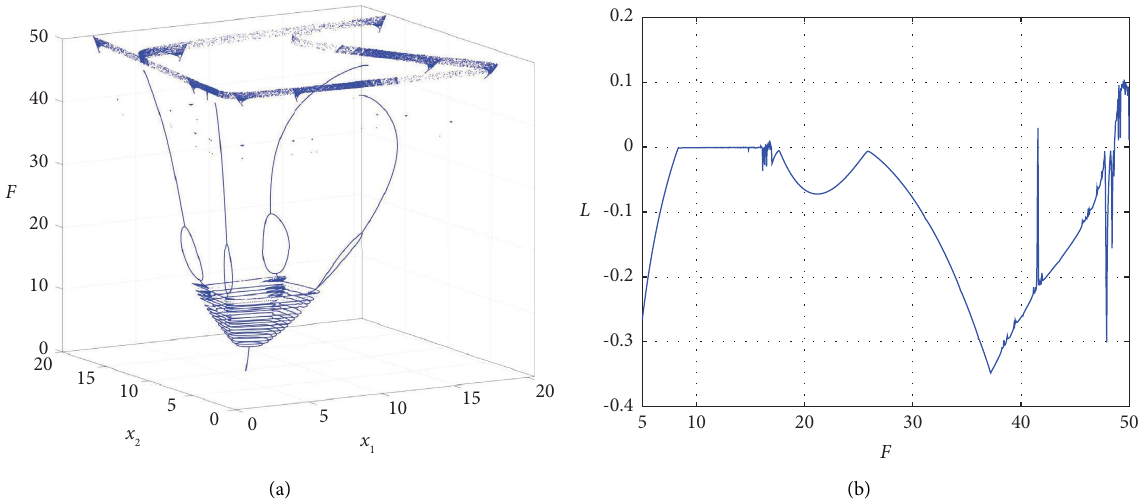
Figure 6: (a) Bifurcation diagram generated by map (2), ( μ , μ , p ) � ( 1 , 0 . 1 , 0 . 9 ) (2), ( μ 1 2